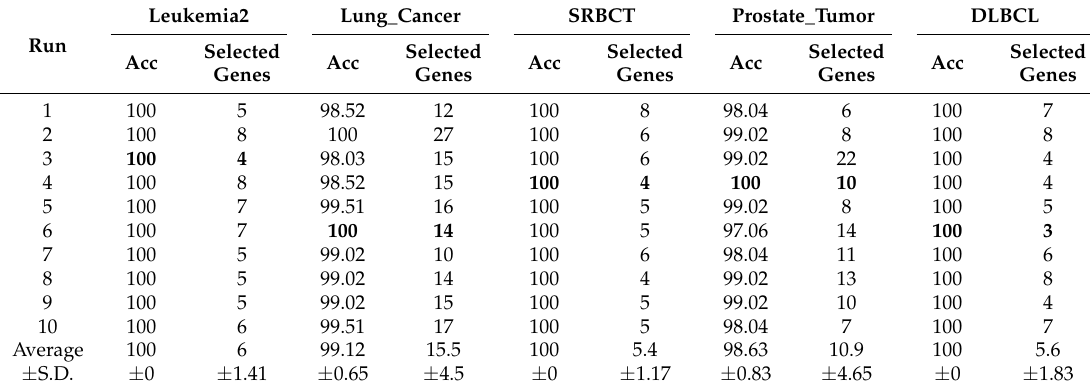
Table 4. Experimental results for each run using MOBDE on Leukemia2, Lung_cancer, SRBCT, Prostate_Tumor and